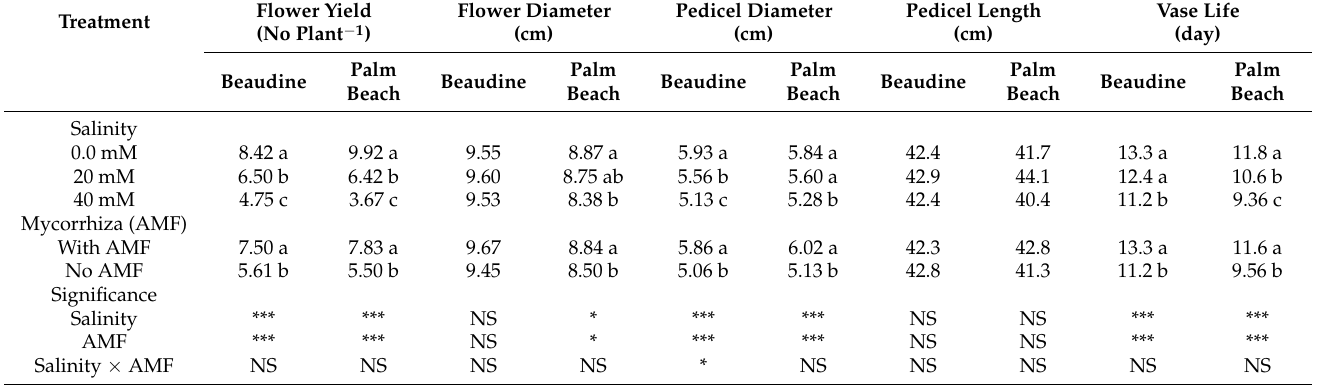
Table 3. Flower yield and quality component of gerbera cultivars (‘Beaudine’ red; ‘Palm Beach’ yellow) inoculated (AMF) or uninoculated (No AMF), grown under different salt stress levels in 2018.